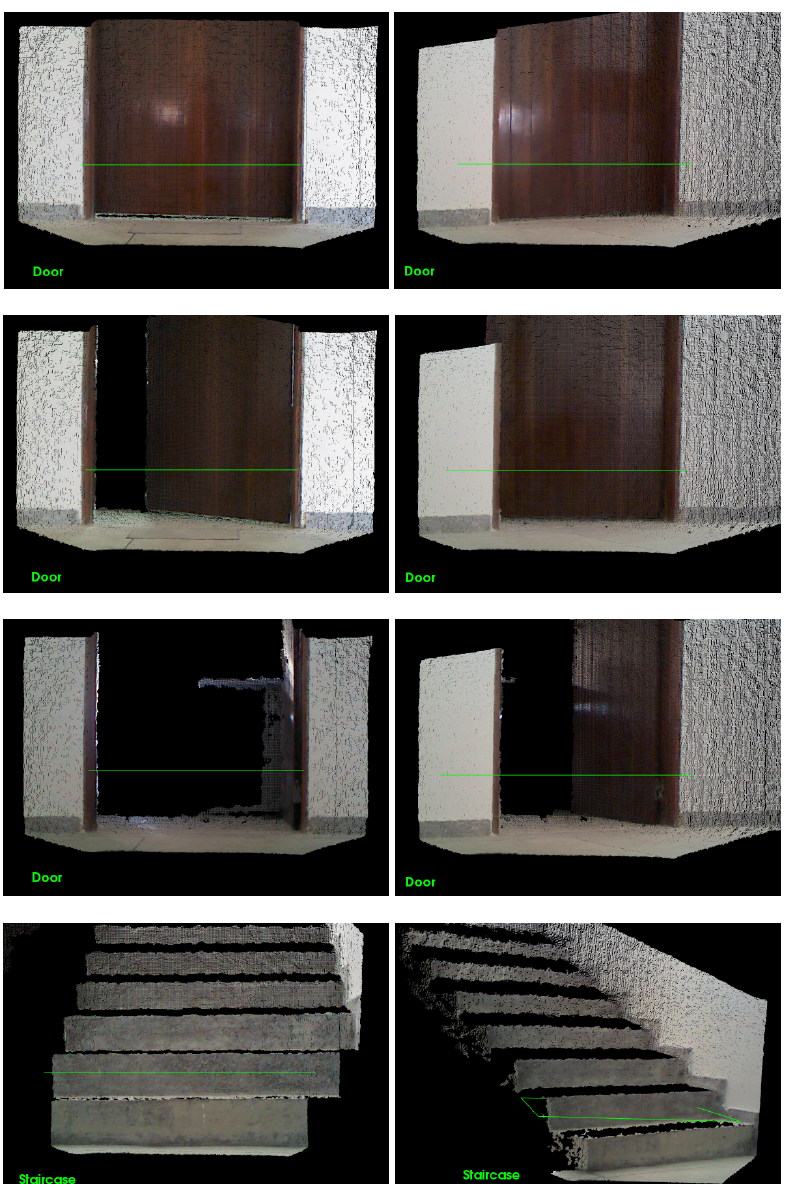
Figure 9. Recognition results. From top to bottom, left to right we see the detection of a closed door in 0 degree angle, a closed door in 45 degree angle, a partially closed door in 0 degree angle, a partially closed door in 45 degree angle, an open door in 0 degree angle, an open door in 45 degree angle, stairs in 0 degree angle and stairs in 45 degree